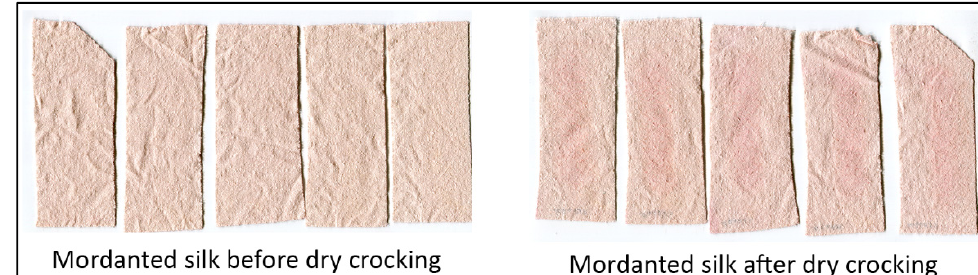
Figure 8. Mordanted silk dyed with draconin red before and after crocking.